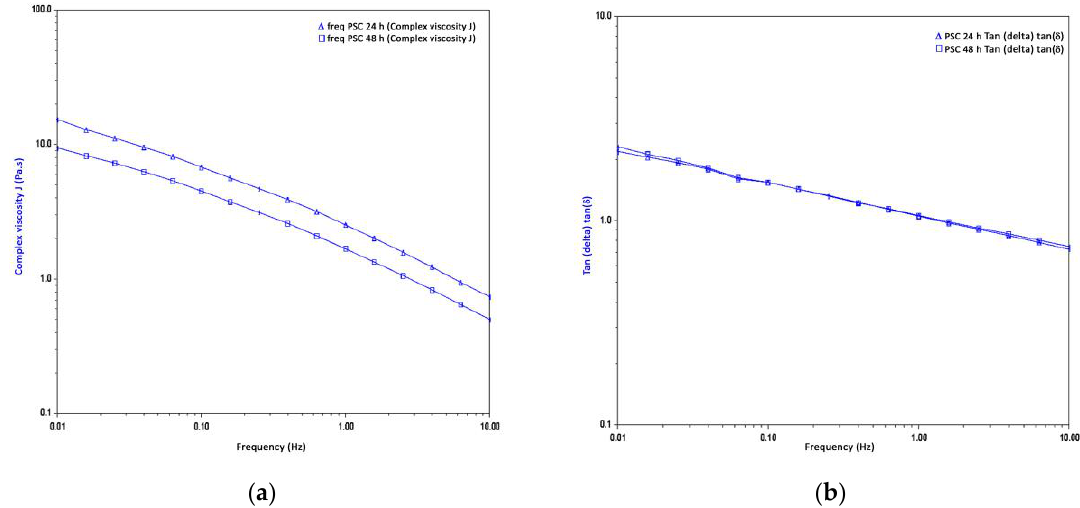
Figure 4. The frequencies of ( a ) complex viscosity (η*) and ( b ) loss tangent (tan δ) of collagen solution of extracted PSC at 24 and 48 h extraction time of silver catfish.